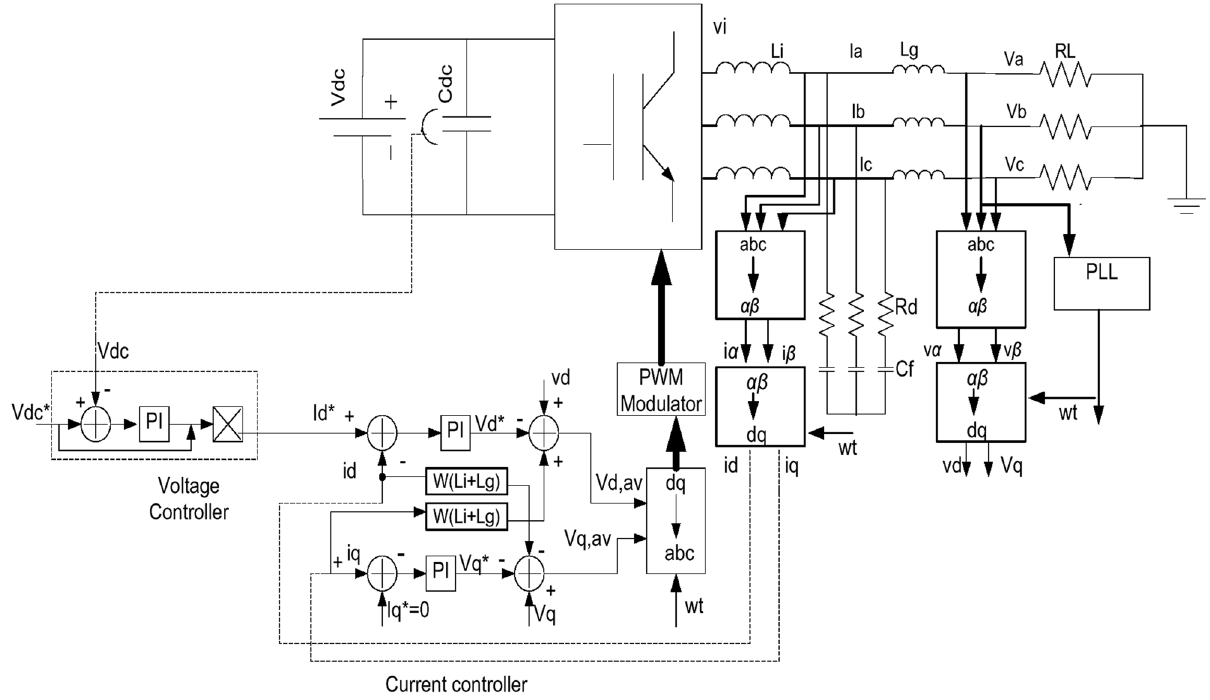
Figure 3: Standalone PV system with its control scheme in dq reference